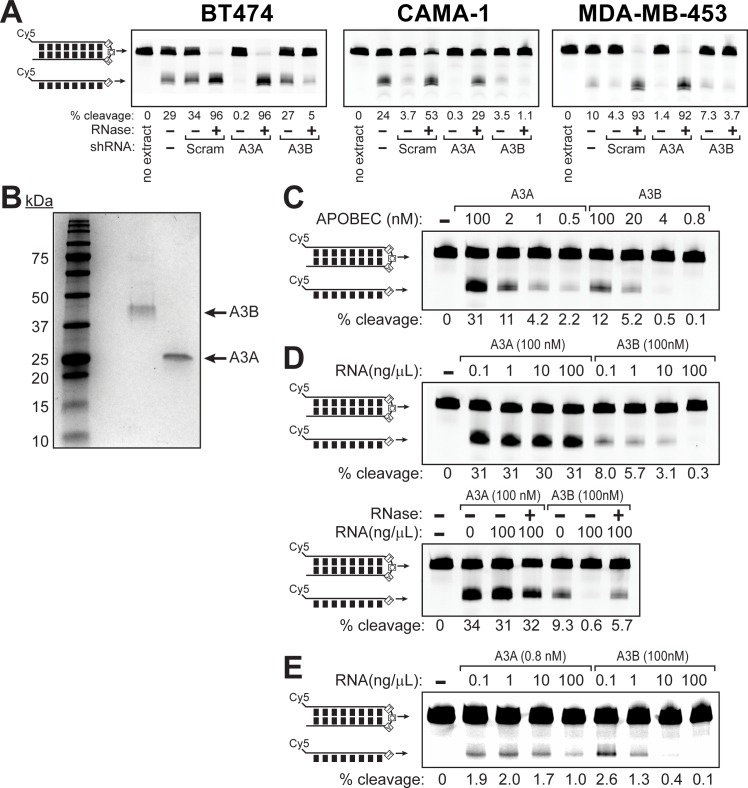
APOBEC3A and APOBEC3B are differentially inhibited by RNA.(A) In vitro cytidine deaminase assays conducted similarly to those in Fig 1D and 1E, but using extracts for BT474, CAMA-1 and MDA-MB-453 cells transduced to express scramble (Scram) shRNA controls or A3A- and A3B-targeted shRNAs. Prior to incubating the extracts with the hairpin DNA substrate, extracts where either mock-treated or treated with 2.5 μM RNaseA at 37°C for 30 min. (B) Coomassie stained SDS-PAGE showing the purity of A3A (23 kDa) and A3B (42 kDa) over-expressed in and purified from HEK293T cells. (C) The activity of purified A3A and A3B was compared in vitro by incubating 0.25 μM hairpin DNA substrate with decreasing concentrations of A3A or A3B for 30 min at 37°C in the presence of uracil DNA glycosylase. Reactions were heated at 95°C for 10 min in formamide loading buffer prior to resolving on a denaturing polyacrylamide gel. (D) Increasing amounts of total RNA isolated from BT474 cells were added to in vitro cytidine deaminase assays containing 100 nM of either A3A or A3B and 0.25 μM of hairpin DNA substrate to assess the relative impact of RNA on A3A and A3B activity. Additionally, reactions containing 100 ng/μL of RNA were either mock treated or treated with RNaseA to ensure inhibition of cytidine deaminase activity was due to interactions with RNA. (E) To assess RNA inhibition of A3A and A3B at similar enzymatic activities, 0.8 nM A3A and 100 nM A3B where incubated with 0.25 μM of hairpin DNA substrate and increasing RNA concentrations. Samples in (D) and (E) were processed as in (C).